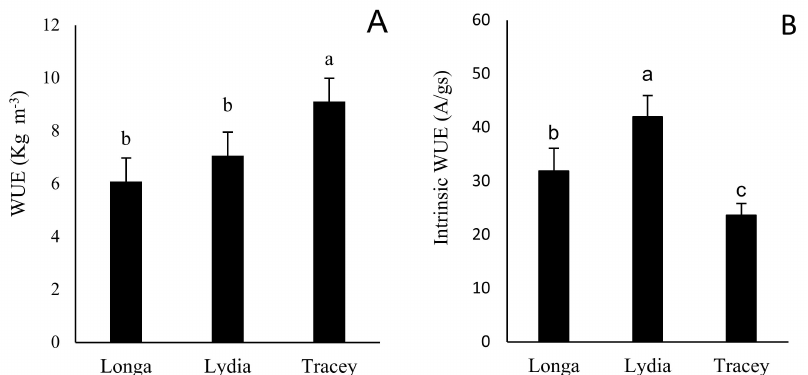
Figure 6. Water use efficiency (WUE) ( A ) and intrinsic WUE (iWUE) ( B ) in the high − tech greenhouse. Data are averaged over 6 weeks of measurements with 6 biological replicates for each cultivar per week. Different lowercase letters indicate statistical significance at p <